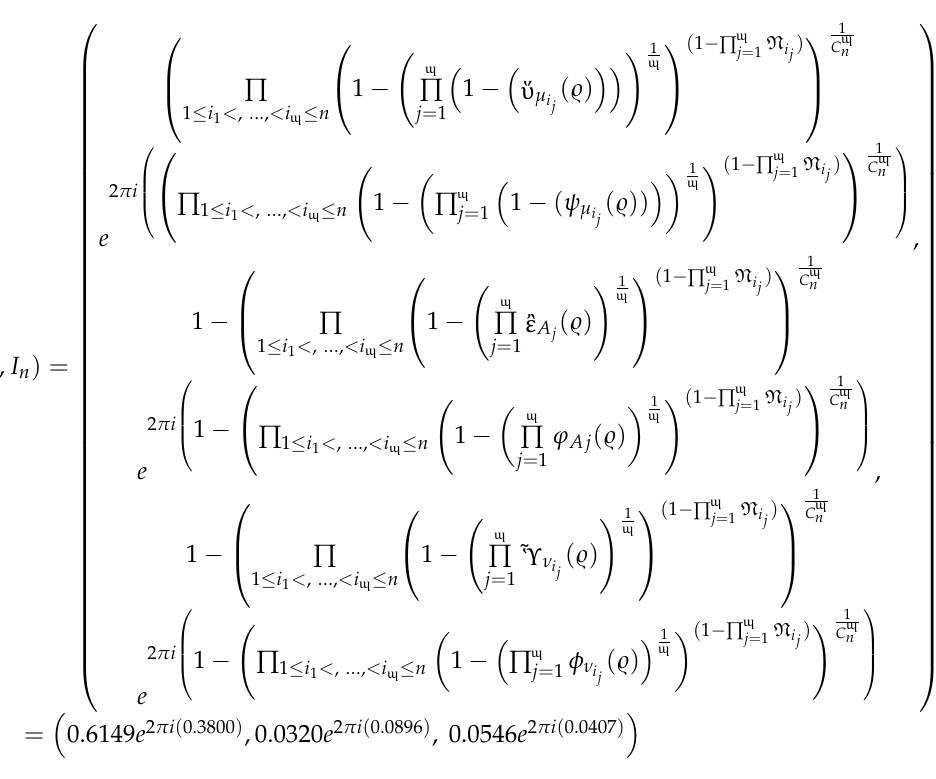
Table 1. Symbols and their meanings.